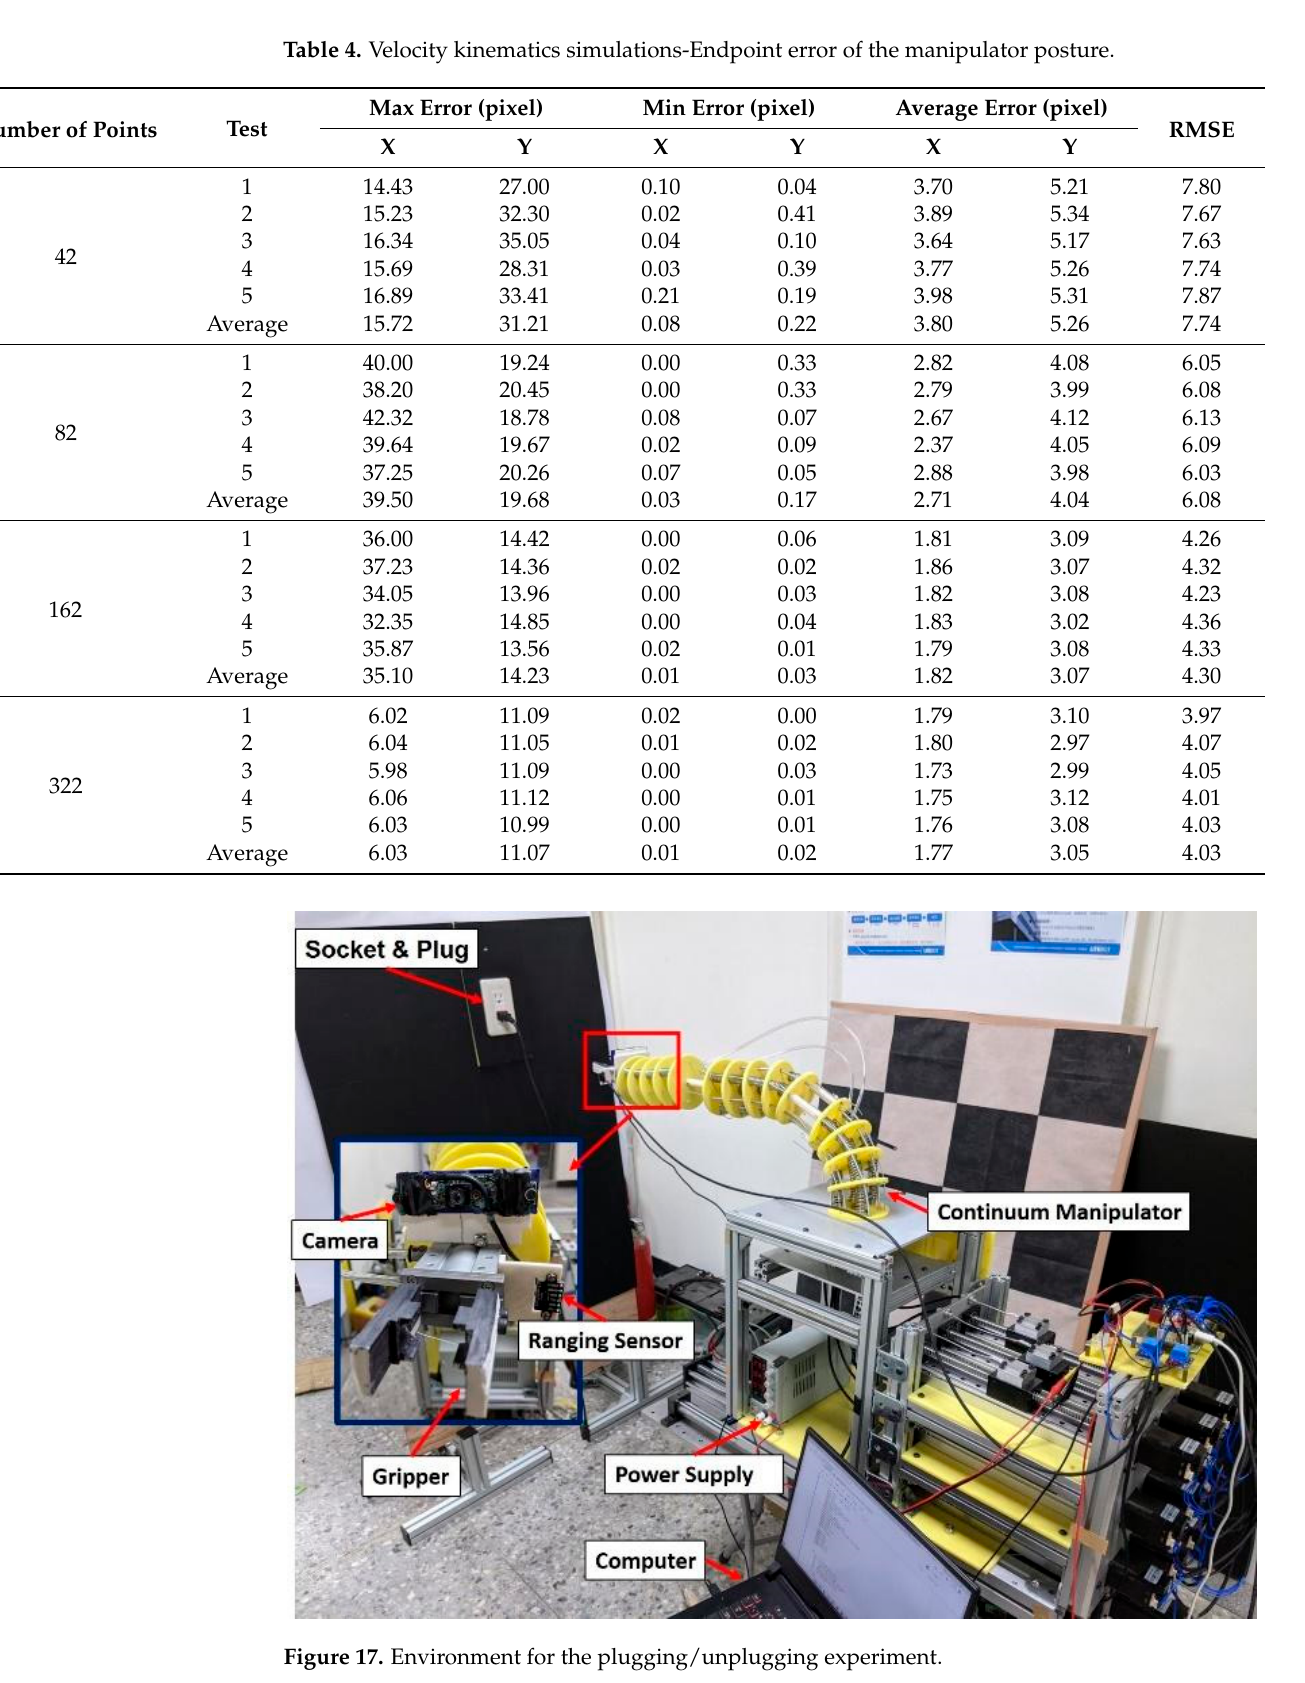
Figure 18. The algorithm flowchart of the Plugging/Unplugging task. The experiment has two main parts: plugging and pulling the plug. In both experi- ments, the socket and plug specifications are in Figure 19. A widely used object detection open-source framework, YOLOv4 [39], was used to identify the target area first, and then